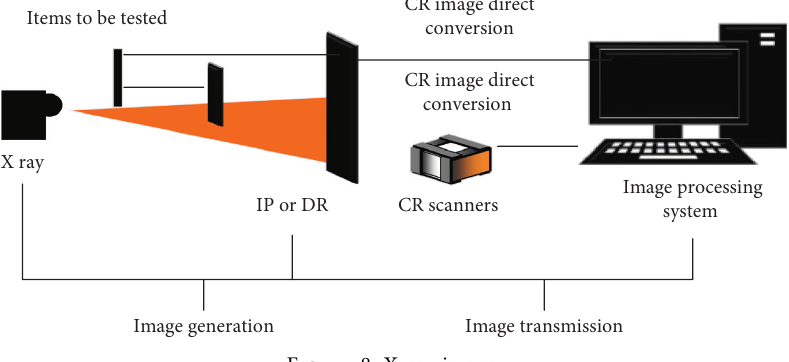
Figure 8: X-ray image.